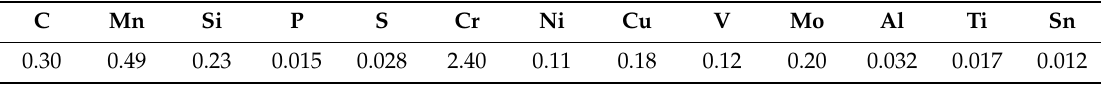
Table 1. Chemical composition of steel 31CrMoV9 (wt%), Fe Bal.